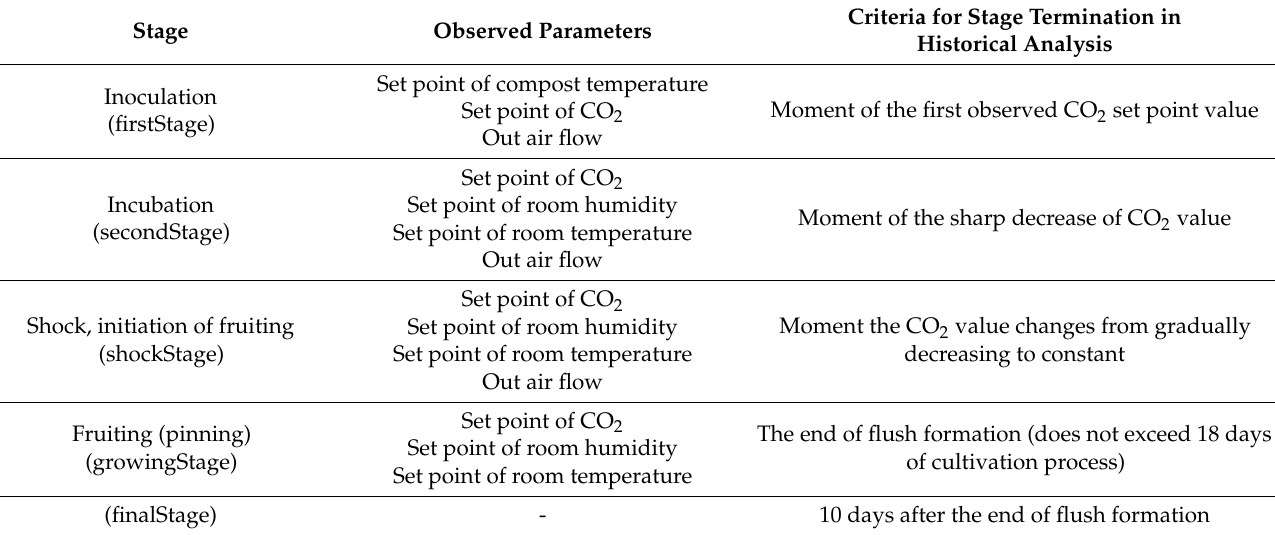
Table 1. Climate parameters observed in different stages of the production cycle and their termination conditions.